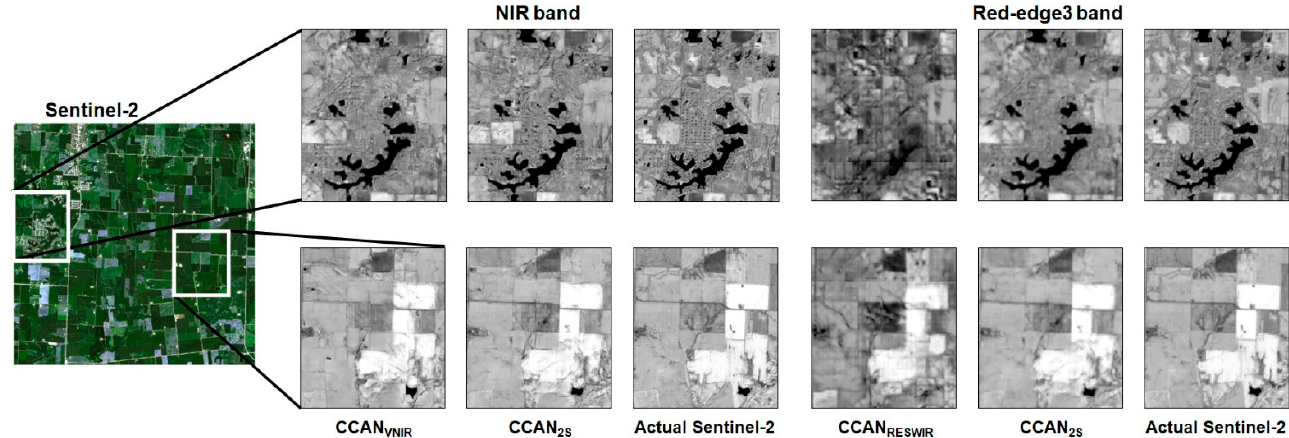
Figure 11. Prediction results of NIR and red-edge3 bands for different CGAN models with the actual Sentinel-2 imagery. The two subareas marked with white boxes in the Sentinel-2 imagery are enlarged.